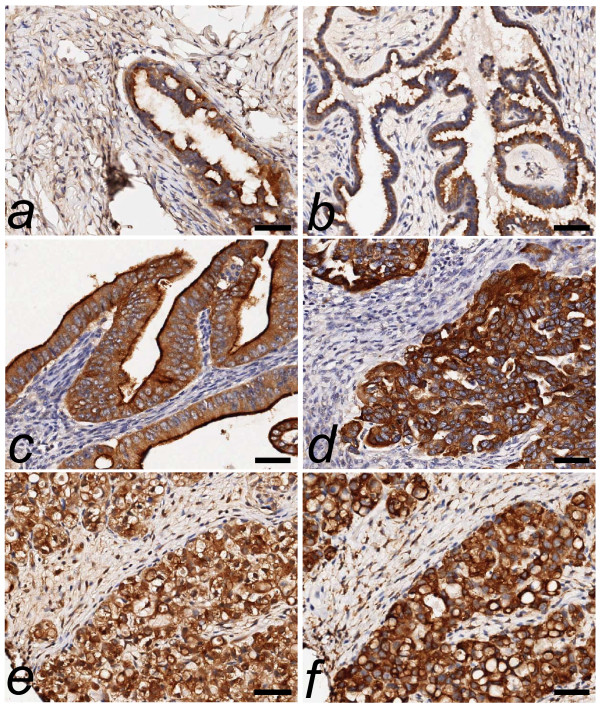
Immunohistochemical detection of MAL2 or TPD52 (brown staining) within paraffin-embedded ovarian tissue sections counterstained with hematoxylin. MAL2 staining within a (a) benign serous lesion; (b) serous borderline lesion; (c) mucinous borderline lesion; (d) serous carcinoma; (e) clear cell carcinoma; and (f) TPD52 staining in the same clear cell carcinoma shown in (e) for comparison. Scale bar = 50 μm.